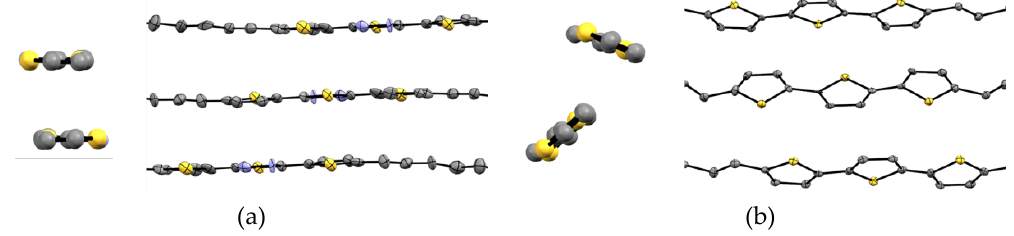
Figure 8. Packing of adjacent molecules in Th-Thd-Th(10) ( a ) and Th 3 (8) ( b ) as viewed along the long axis of the molecule (left) and the short axis of the molecule (right). Legend: sulphur in yellow, nitrogen in light blue, carbon in grey, hydrogens omitted for clarity.